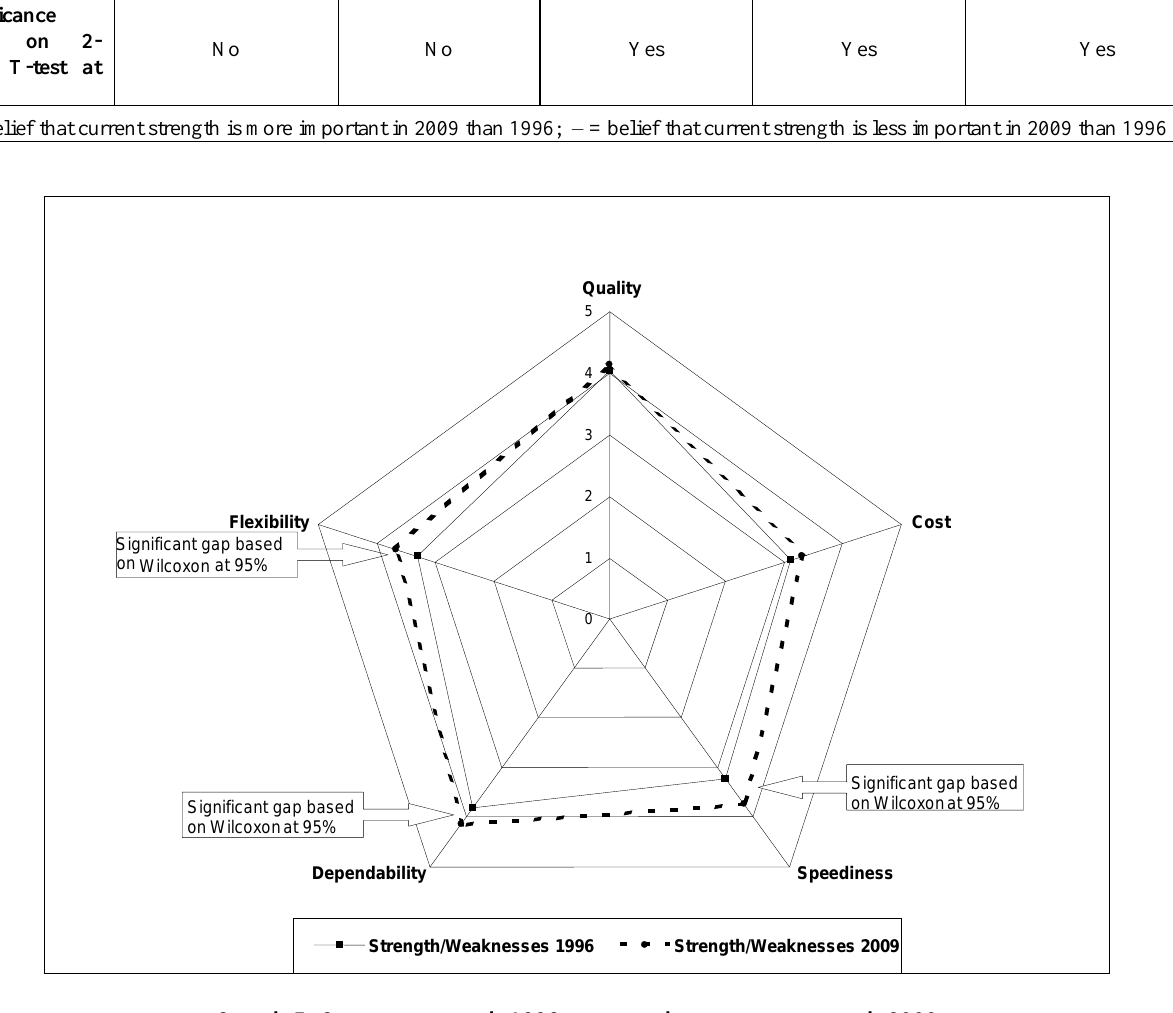
Graph 5: Current strength 1996 compared to current strength 2009 Table 12: Future importance nationally: 1996 versus 2009